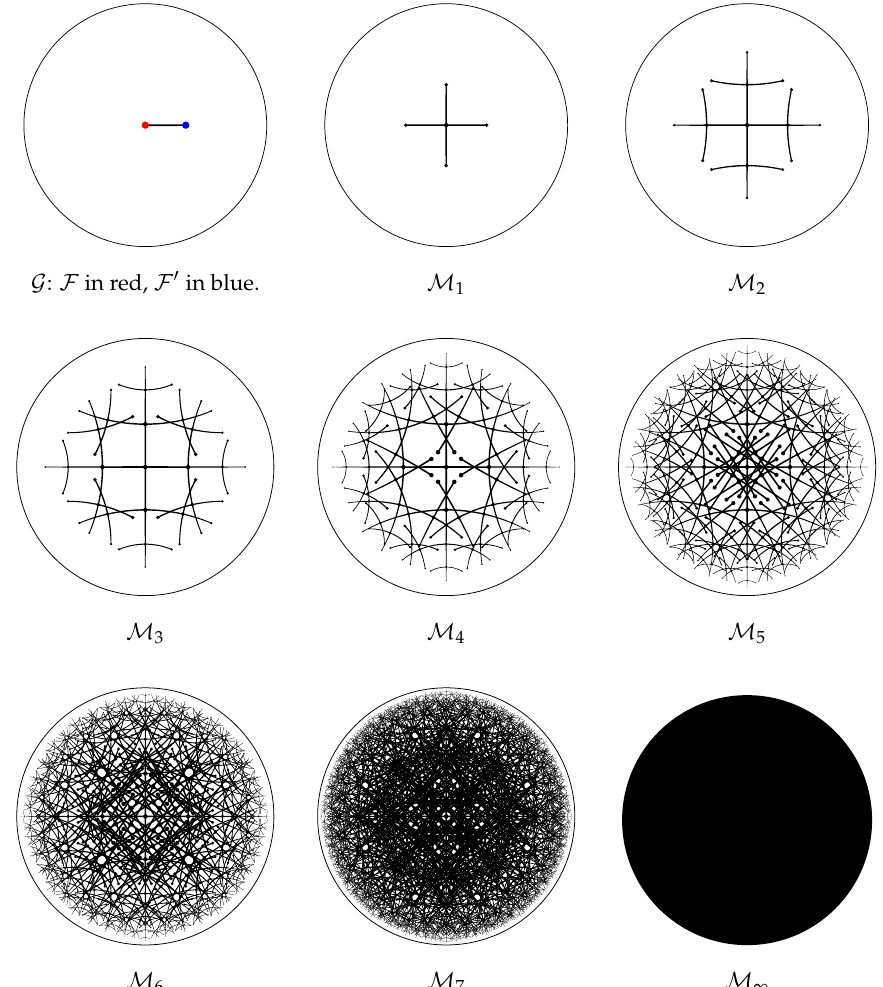
Figure 4. Depicted are nine Poincaré disk representations of the hyperbolic space of the Lorentz group. Each dot represents one frame-grid. If two dots are connected by one line, they are interlaced, as previously described, corresponding to a Lorentz boost with a rapidity w = ln ( 2 ) . The first disk corresponds to Figure 3 of the previous section. The other eight disks are 2D cross sections